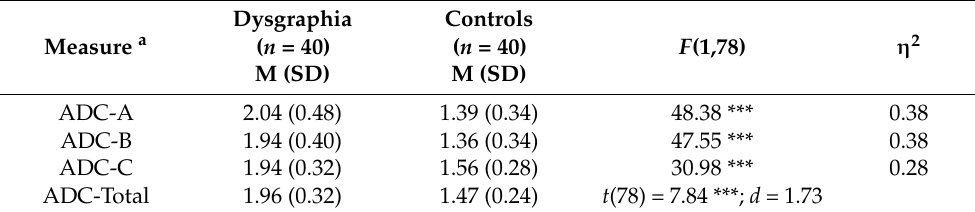
Table 4. Comparison between groups in motor-coordination performance